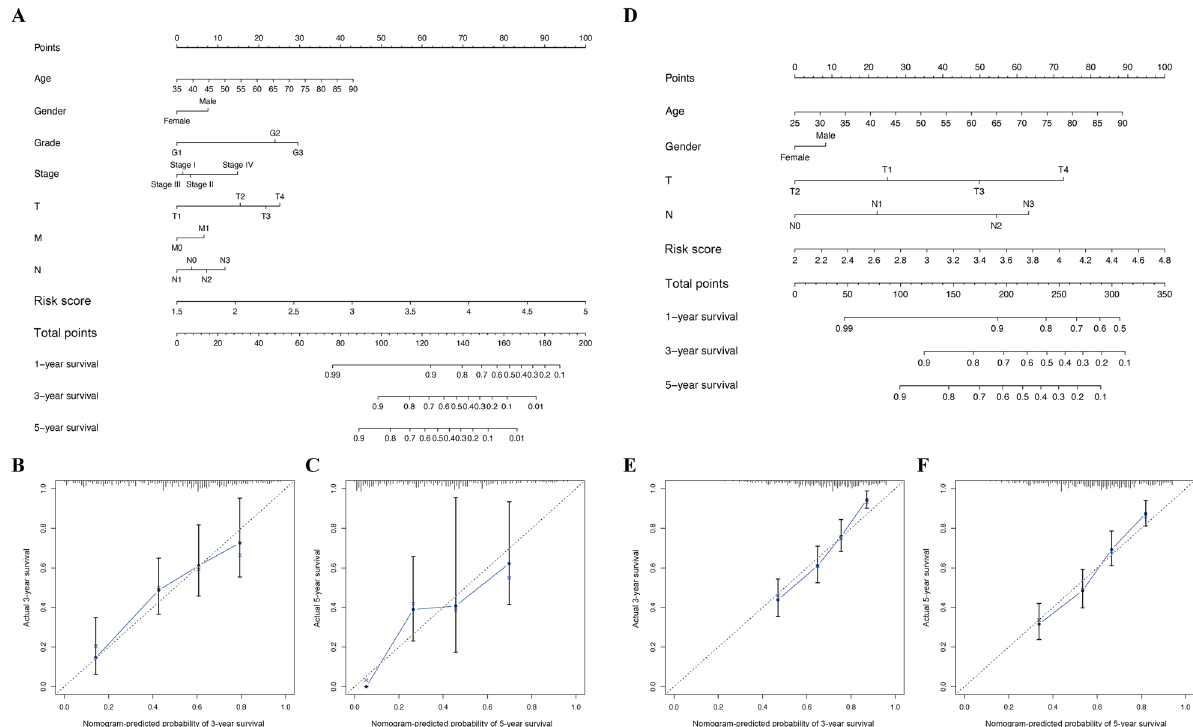
Figure 8. Nomogram plots construction. Nomogram of risk score and other clinical factors for predicting GC 1-, 3-, and 5-year overall survival in TCGA ( A ) and GSE84437 ( D ) cohort. ( B – C ) The calibration plot of the nomogram in TCGA cohort. ( E – F ) The calibration plot of the nomogram in GSE84437